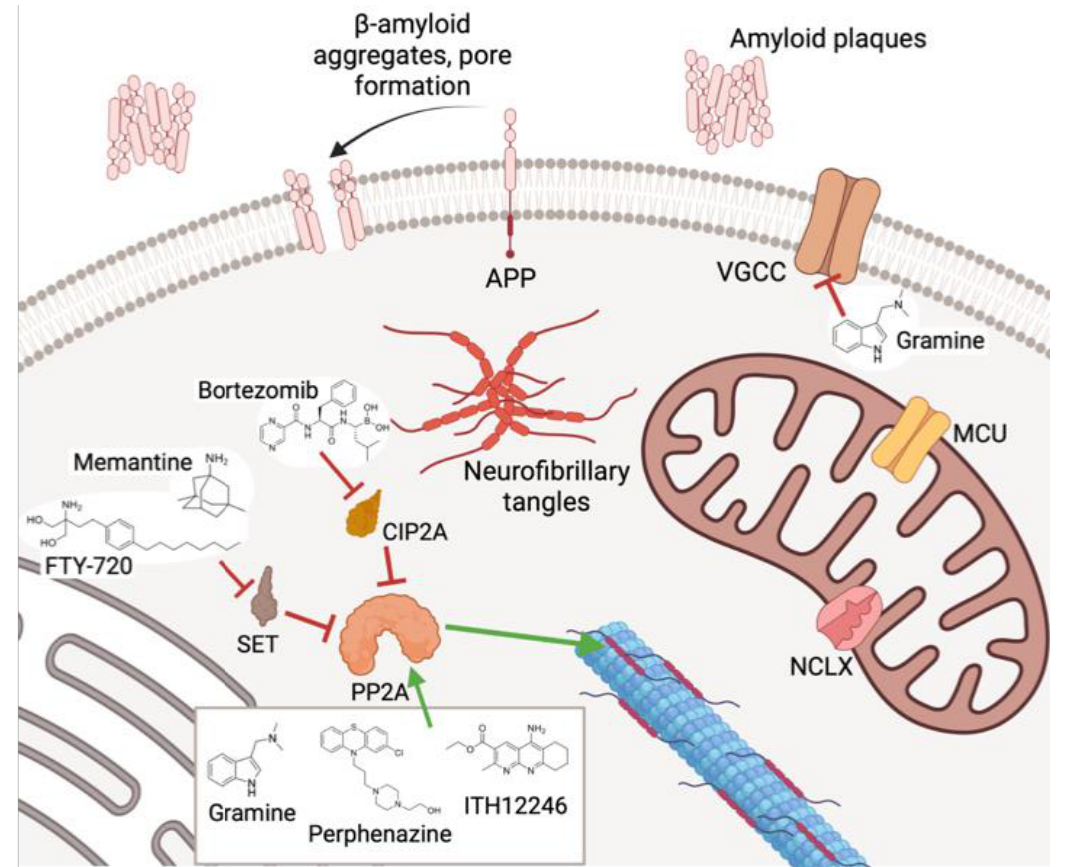
Figure 11. Pharmacological modulation of PP2A activity by different strategies.